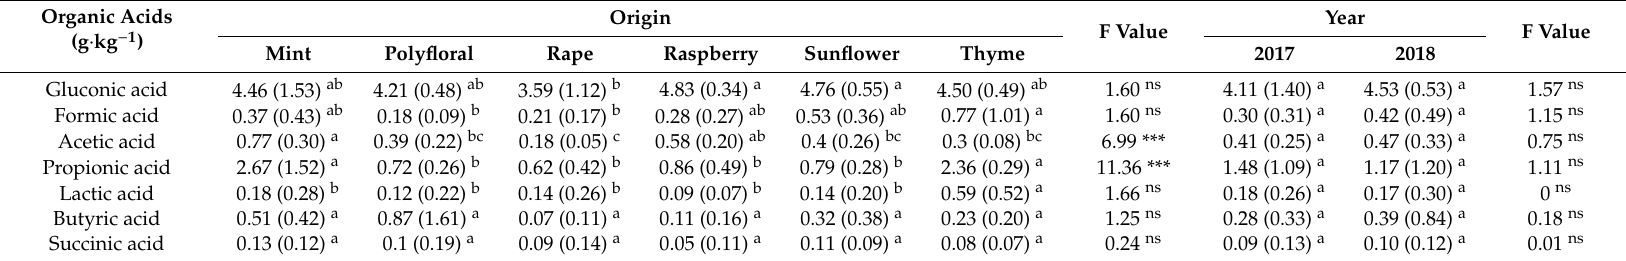
Table 5. Organic acids content for di ff erent types of Romanian honey. Mean values and standard deviation in